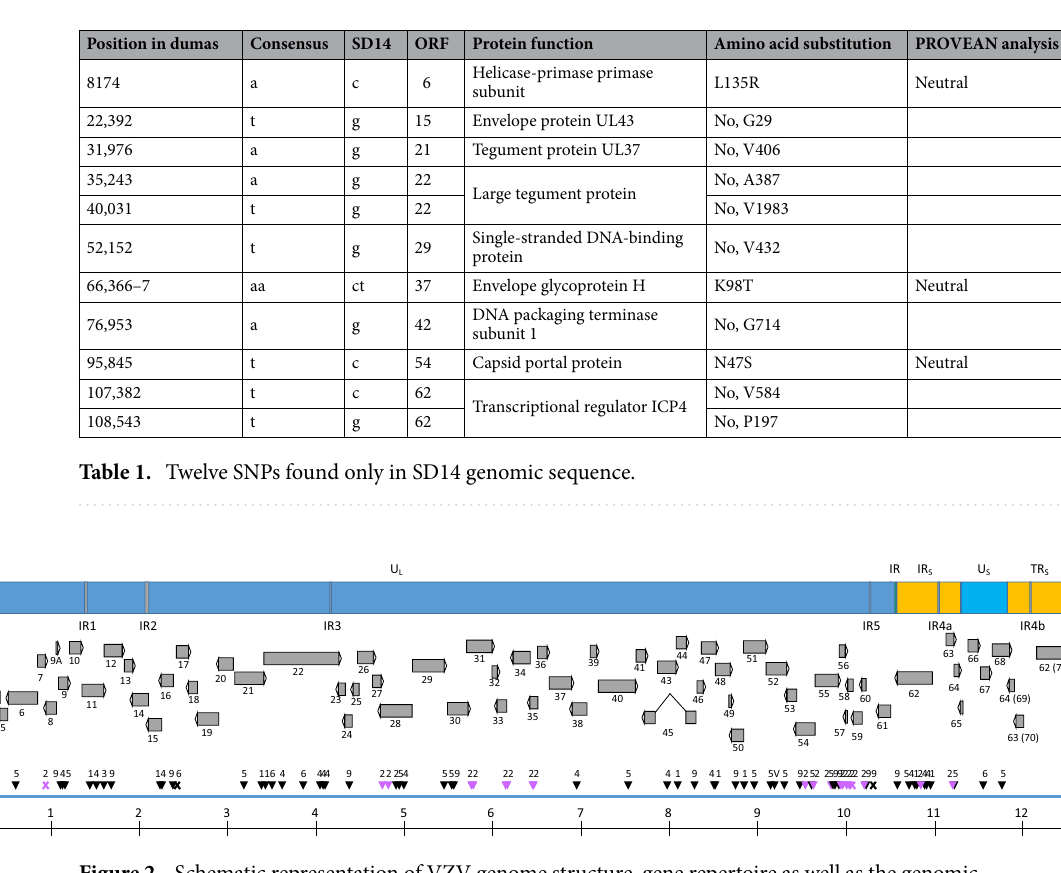
Figure 2. Schematic representation of VZV genome structure, gene repertoire as well as the genomic distribution of clade specific markers. Genomic regions are represented as color-coded boxes, in blue for unique regions (dark for U L and light for U S ), in green for repeat long (TR L and IR L ), in grey for internal repeats (IR1, 2, 3, 4a, 4b and 5) and in orange for repeat short (IR S and TR S ). ORFs are shown as grey arrows, rightward ORFs on the top and leftward ORFs on the bottom. Clade specific markers are shown as either triangles if they are within an ORF or an “X” if they are outside an ORF. Clades are indicated by a number (1, 2, 3, 4, 5, 6 or 9) or “V” in case of the vaccine marker. Marker specific to clade 2 are shown in purple. The genome is depicted by a thick line in the